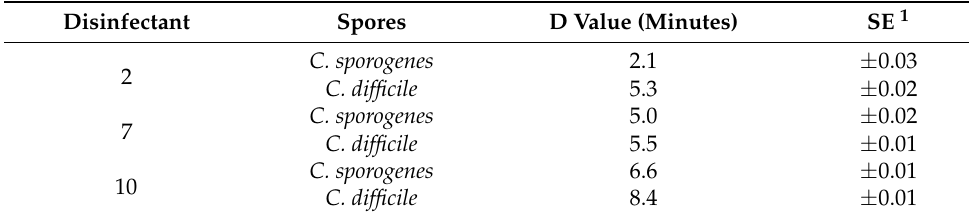
Figure 1. Inactivation of Clostridium sporogenes by disinfecting agents (Disinfectants 2 ( A ), 7 ( B ) and 10 ( C )). Solid line represents the observed values over different time points. The straight line represents the linear regression to determine the slope, to calculate D-values.